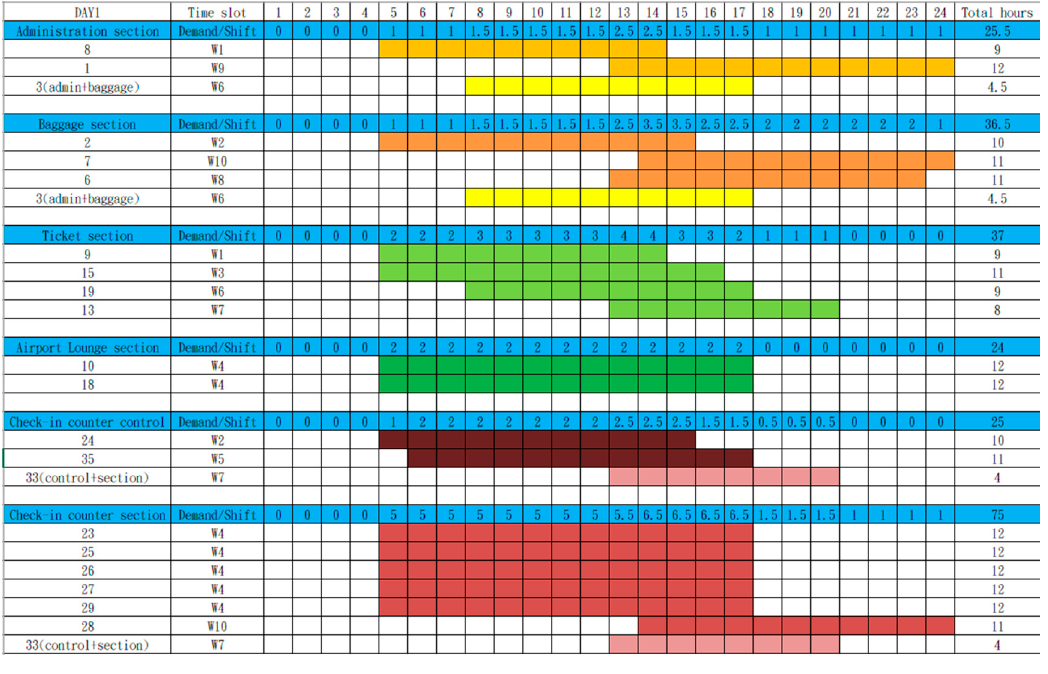
Figure 5. Daily schedule output.